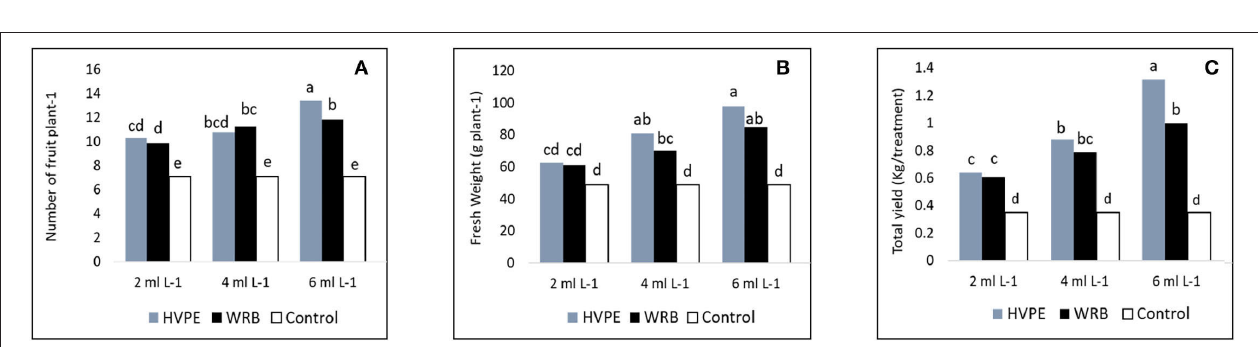
FIGURE 3 | The number of fruits plant-1, fresh weight of fruit plant-1, and the total yield (A–C) of bell pepper untreated plants (Tr0), treated with 2mL L − 1 (HVPE-1), 4mL L − 1 (HVPE-2), 6mL L − 1 (HVPE-3) of the HVPE. Additionally, with 2mL L − 1 (WRB-1), 4mL L − 1 (WRB-2), 6mL L − 1 (WRB-3) of the WRB. Number of fruit plant -1 (A) ; Fresh Weight (B) , and Total yield (C)